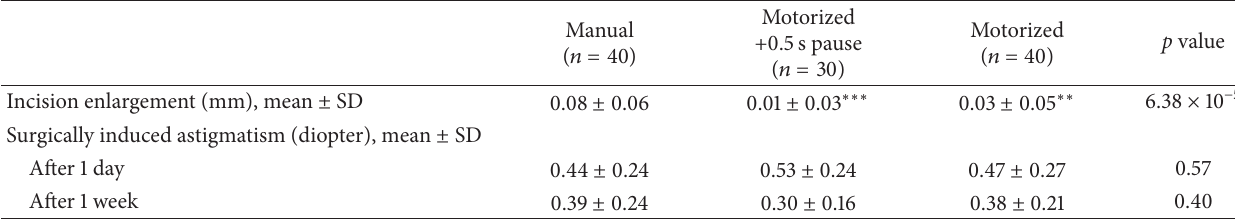
Table 2: Postoperative demographic data for the patients.